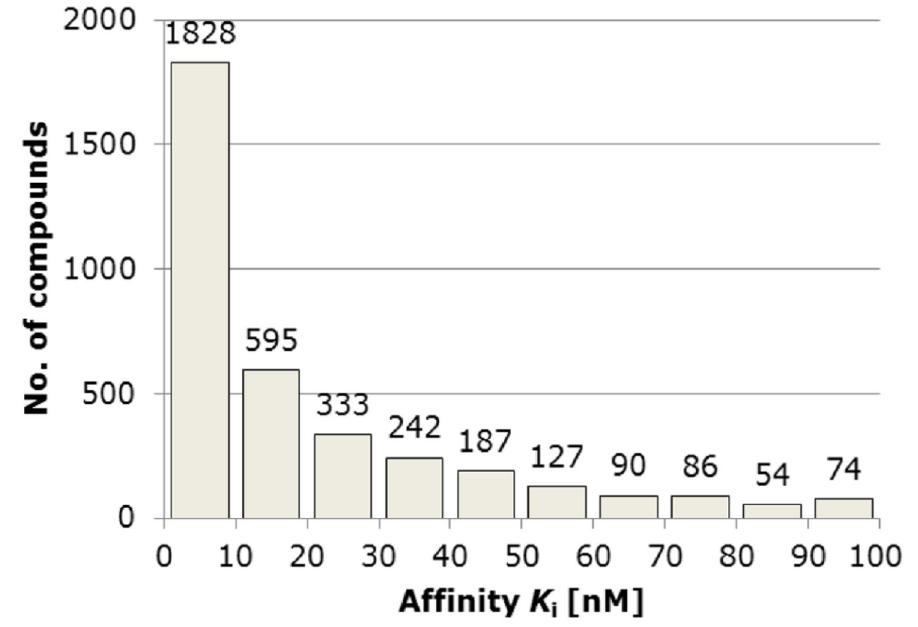
R ligands retrieved from the ChEMBL database version 5. Affinity distribution of 1A